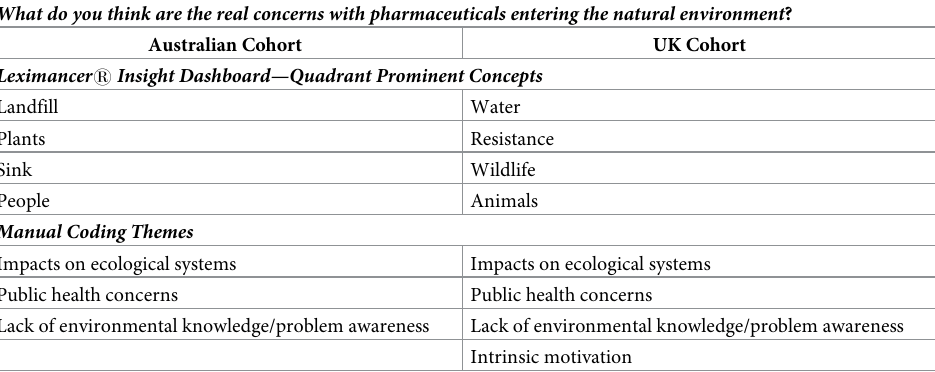
Table 3. Comparison of environmental knowledge between Australian and UK cohorts–knowledge of